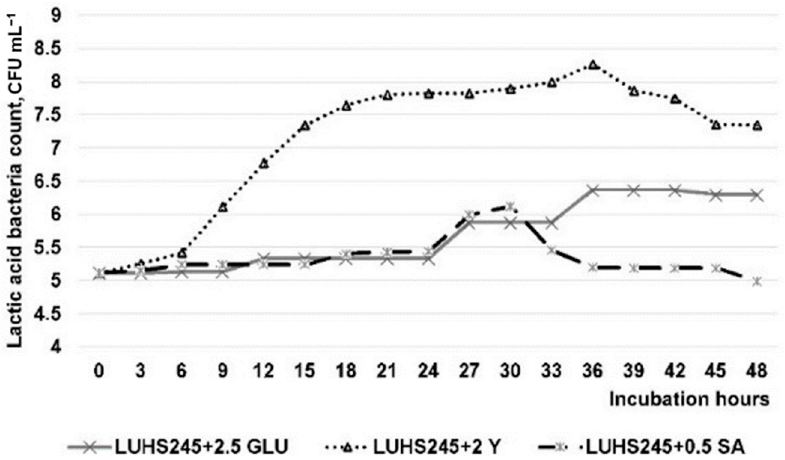
Figure 1. Lactobacillus uvarum LUHS245 biomass growth in dairy by-products media enriched with the optimum concentration of selected additives (LUHS245 + 2.5 GLU—whey enriched with 2.5% glucose and fermented with LUHS245; LUHS245 + 2 YE—whey enriched with 2.0% yeast extract and fermented with LUHS245; LUHS245 + 0.5 SACC—whey enriched with 0.5% sucrose and fermented with LUHS245).